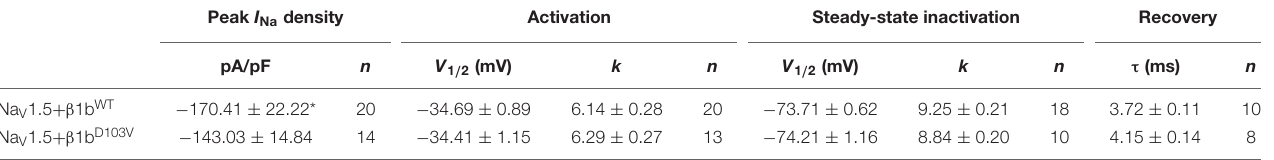
TABLE 4 | Biophysical parameters of HEK cells cotransfected with Na V 1.5 and β 1b WT or β 1b D103V . Peak I Na density Activation Steady-state inactivation Recovery